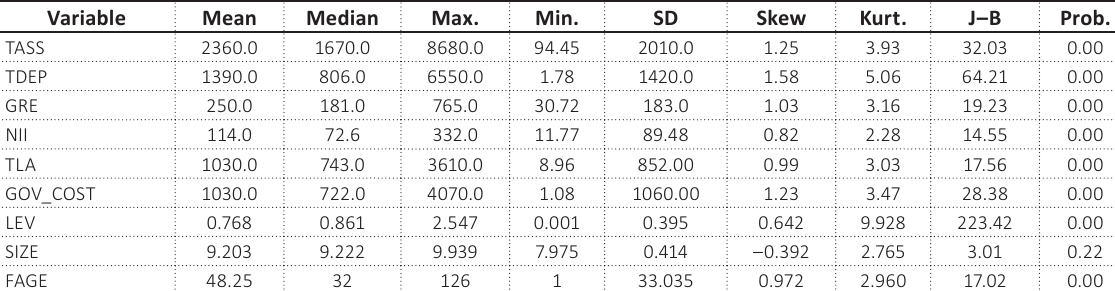
Table 2. Descriptive statistics for banks